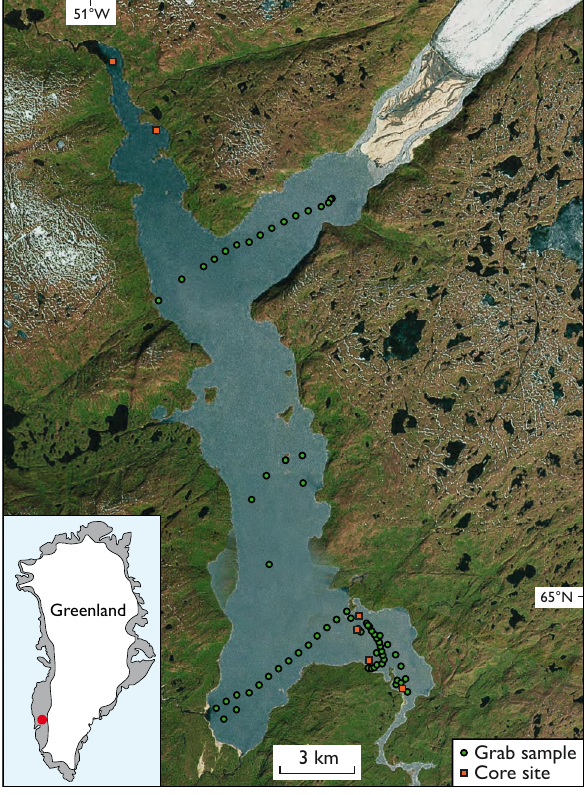
Fig. 1. Satellite image of the Tasersuaq area showing sampling sites. Inset: The location of Tasersuaq in